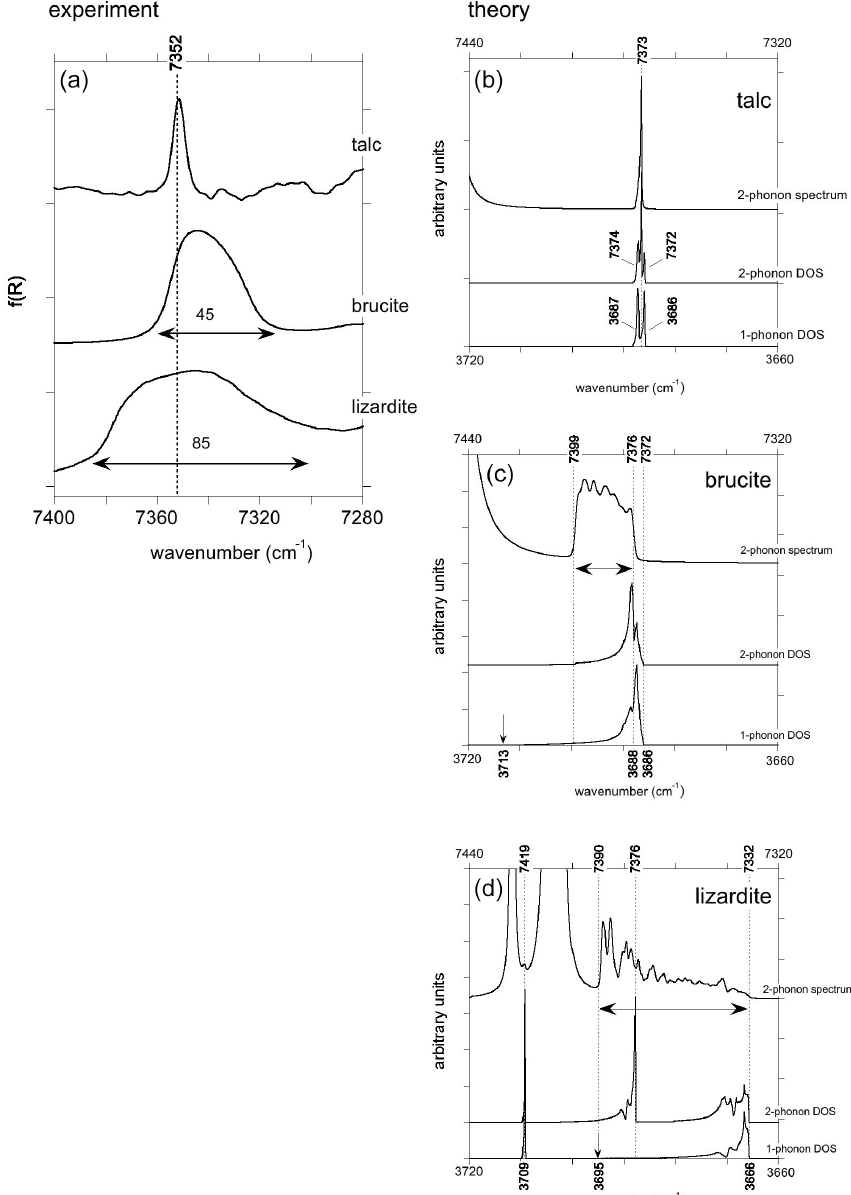
Figure 5. (a) Enlarged view of the experimental absorption bands corresponding to the two-phonon OH stretching continuum in talc, brucite and lizardite. Note the significant variations in the width of the bands. (b, c, d) Theoretical two-phonon DOS and spectral function of OH stretching modes in talc, brucite and lizardite. For an easier comparison the one-phonon DOS is also reported at the bottom with a wavenumber scale multiplied by